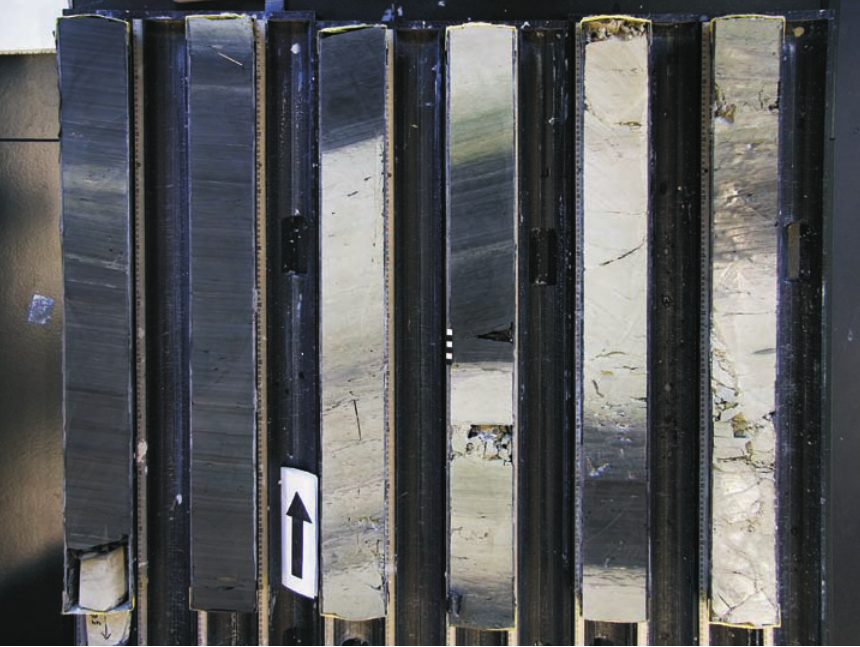
Figure 3. Meters 44 to 38 of the Wunstorf core showing dark laminated black shales.